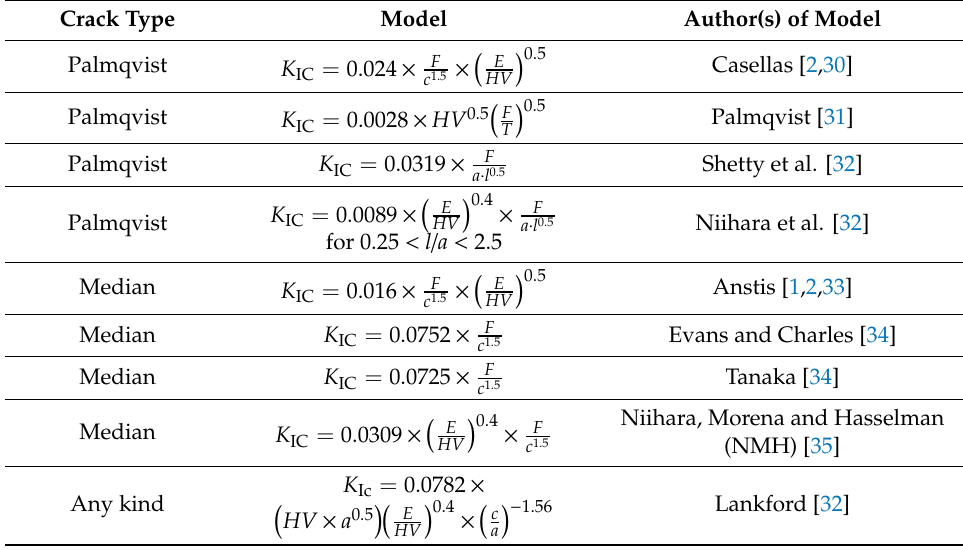
Table 4. Models by di ff erent authors for calculation of Vickers indentation fracture toughness ( K IC ) values for di ff erent crack types